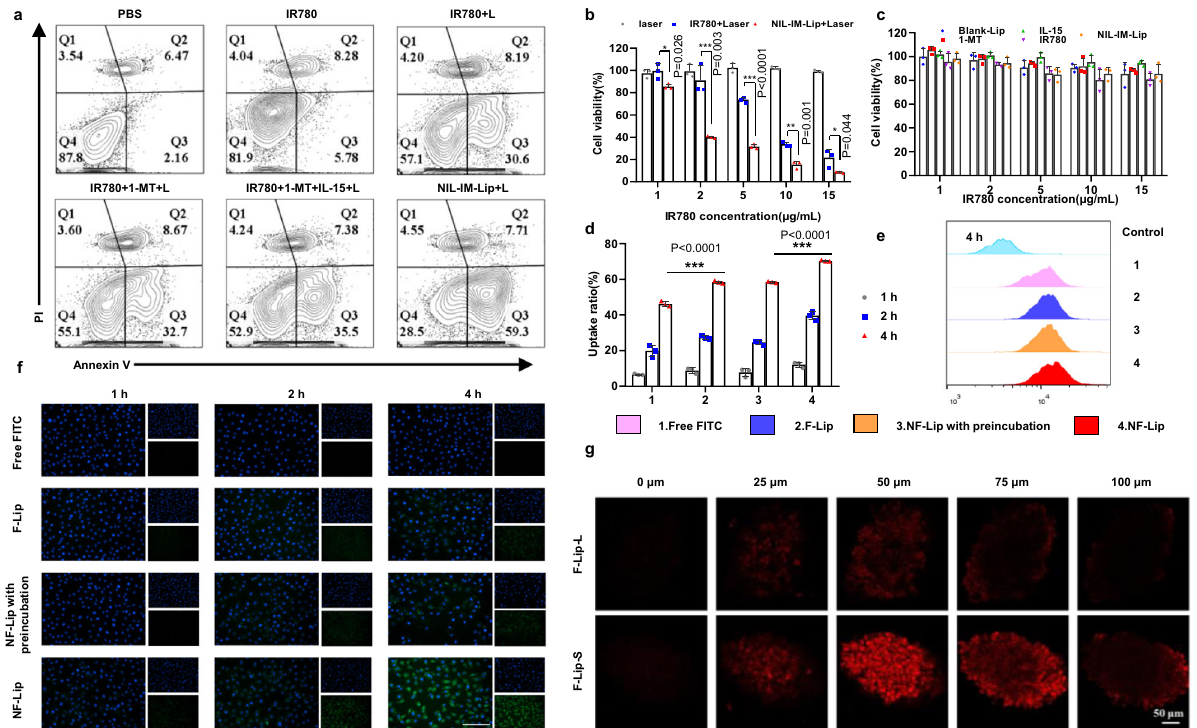
Fig.4|TheinvitroantitumoureffectsofNIL-IM-Liponapoptosis,pH-sensitive disassemblyanddeeptumourpenetration.a Flowcytometricapoptosisanalysis of B16F10 cells after treatment with PBS, IR780, IR780+L, IR780+1-MT+L, IR780+1-MT+IL-15+L and NIL-IM-Lip+L. The IR780+L,